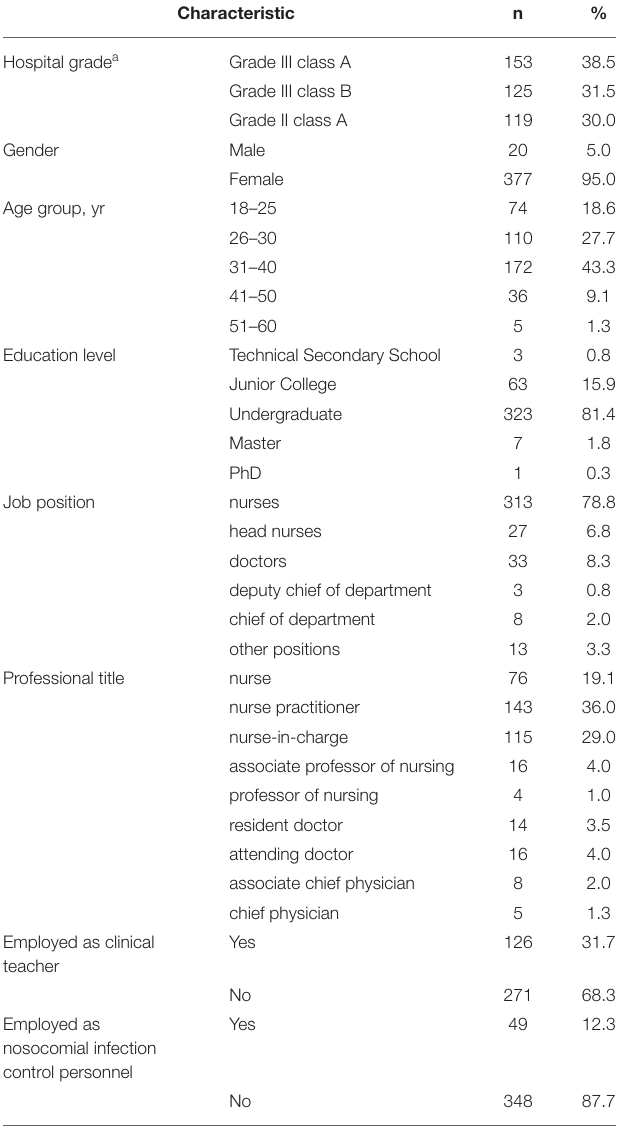
TABLE 1 | Basic characteristics of the study subjects ( n =